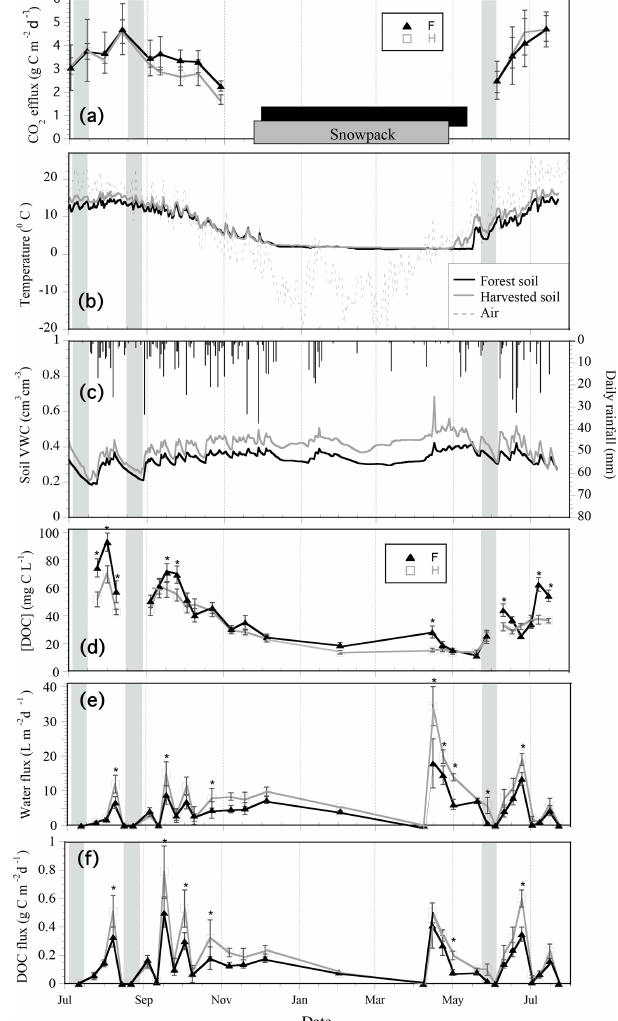
Figure 2. Temporal variation of soil respiration (a) , daily mean soil temperature with the presence of a snowpack indicated by the grey (harvested) and black (forest) bar (b) , daily rainfall and daily mean soil moisture (c) , and lysimeter collections (d, e, f) from July 2013 to July 2014 in black spruce forest and harvested plots. The mean dissolved organic carbon (DOC) concentration (d) , water flux (e) , and DOC flux (f) was determined using passive pan lysimeter col- lections underneath O horizons. Lysimeter sampling was continu- ous, and points represent a mean daily flux over each collection period. Error bars show the standard error of the mean of 12 lysime- ter collections per plot type per collection period. Grey shading ar- eas indicate dry periods signified by those exceeding 10 consecu- tive days of rainfall less than 10mmd − 1 , corresponding to peri- ods of soil drying. Significant differences in DOC flux, water flux, and DOC concentration between plot type on each collection day were determined by repeated-measures linear-mixed-model post hoc tests and are indicated by an asterisk ( α = 0 .